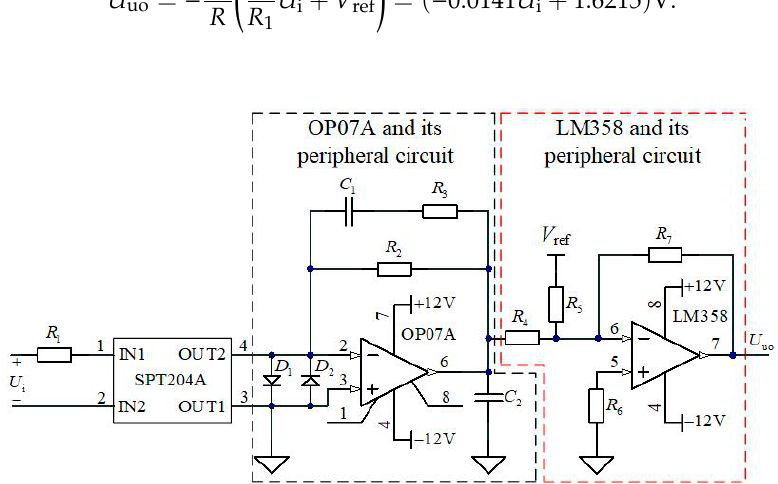
Figure 6. The schematic diagram of the signal conditioning circuit for a voltage transducer.